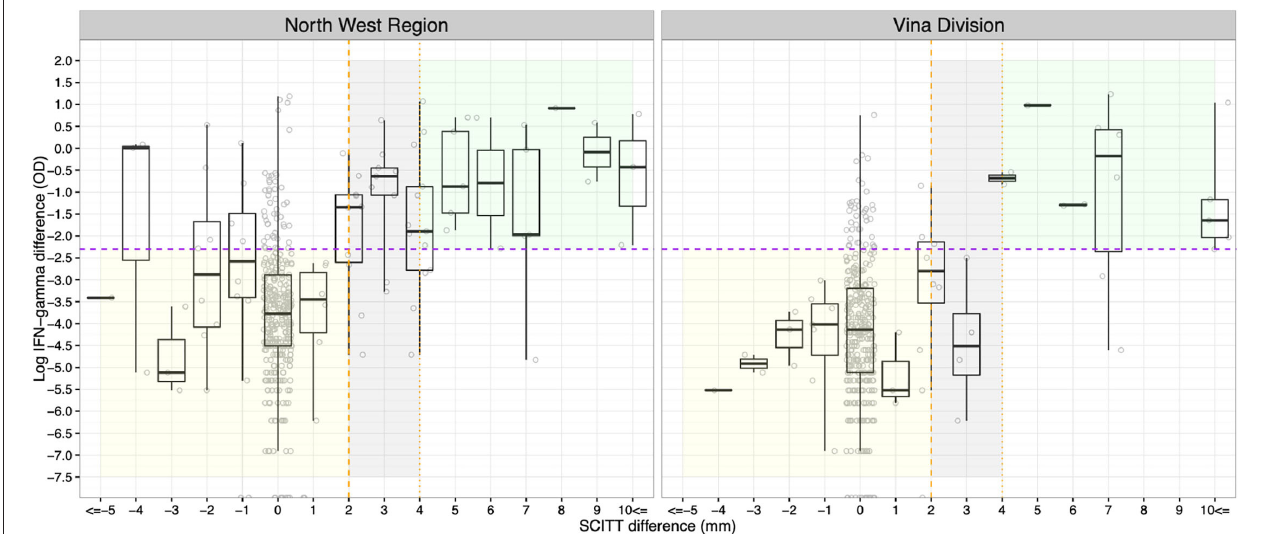
FIGURE 3 | For the IFN- γ assay, results are displayed on a log scale for clarity and ≥ 0.1 positive cut-off values are shown (horizontal purple dashed line; ln (0.1) = − 2.3). For the SCITT > 2mm (vertical orange dashed line) and > 4mm (vertical orange dotted line), positive cut-off values are shown. The green area denotes the test positive cattle for IFN- γ assay ( ≥ 0.1) and SCITT ( > 4mm). The grey area denotes proportion of additional test positive cattle for IFN- γ assay ( ≥ 0.1) and SCITT ( ≥ 2mm). The yellow area denotes test negative cattle for IFN- γ assay ( < 0.1) and SCITT ( ≤ 2mm). TABLE 1 | Comparisons of agreement and Cohen’s κ statistic between IFN- γ assay ( ≥ 0.1) and SCITT ( > 2mm and > 4mm) for pastoral cattle sampled in the North West Region and Vina Division. North West Region ( n = 750) IFN- γ assay ( ≥